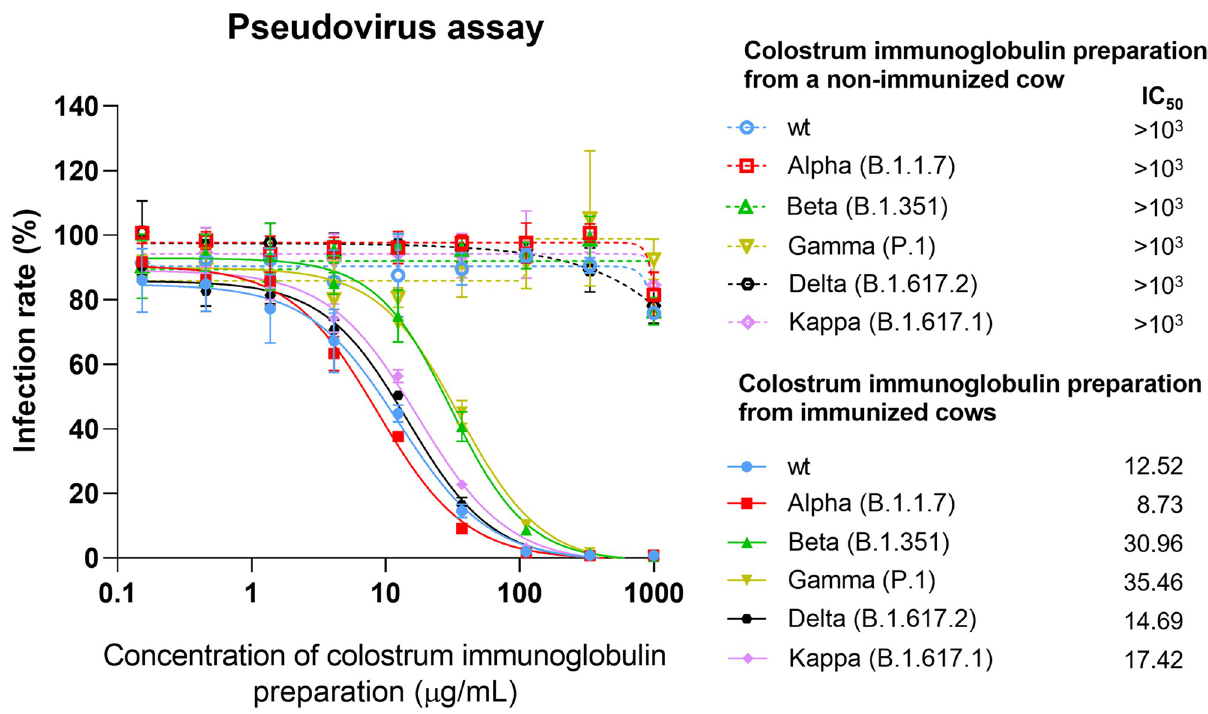
Fig 3. Pseudovirus neutralization assay. Measurement of the inhibition of trimeric S protein-dependent entry of different pseudoviruses pseudotyped with wt, Alpha, Beta, Gamma, Delta or Kappa VoCs of the SARS-CoV-2 S protein into ACE2-expressing HEK293 cells in the presence of serial dilutions of colostrum immunoglobulin preparation. The rate of cell entry was measured via firefly luciferase activity and expressed as the relative infection rate (%) compared to luciferase activity in the untreated control. Data are represented as the mean ± SD (n = 3). The IC 50 concentrations for colostrum immunoglobulin preparation were determined using 4-parameter nonlinear regression.